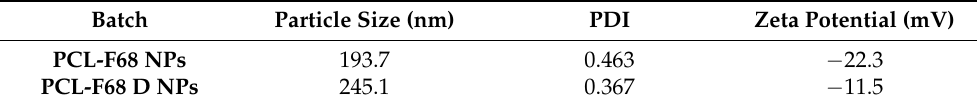
Table 1. Particle size, polydispersity index (PDI), and Zeta potential of formulated nanoparticles.